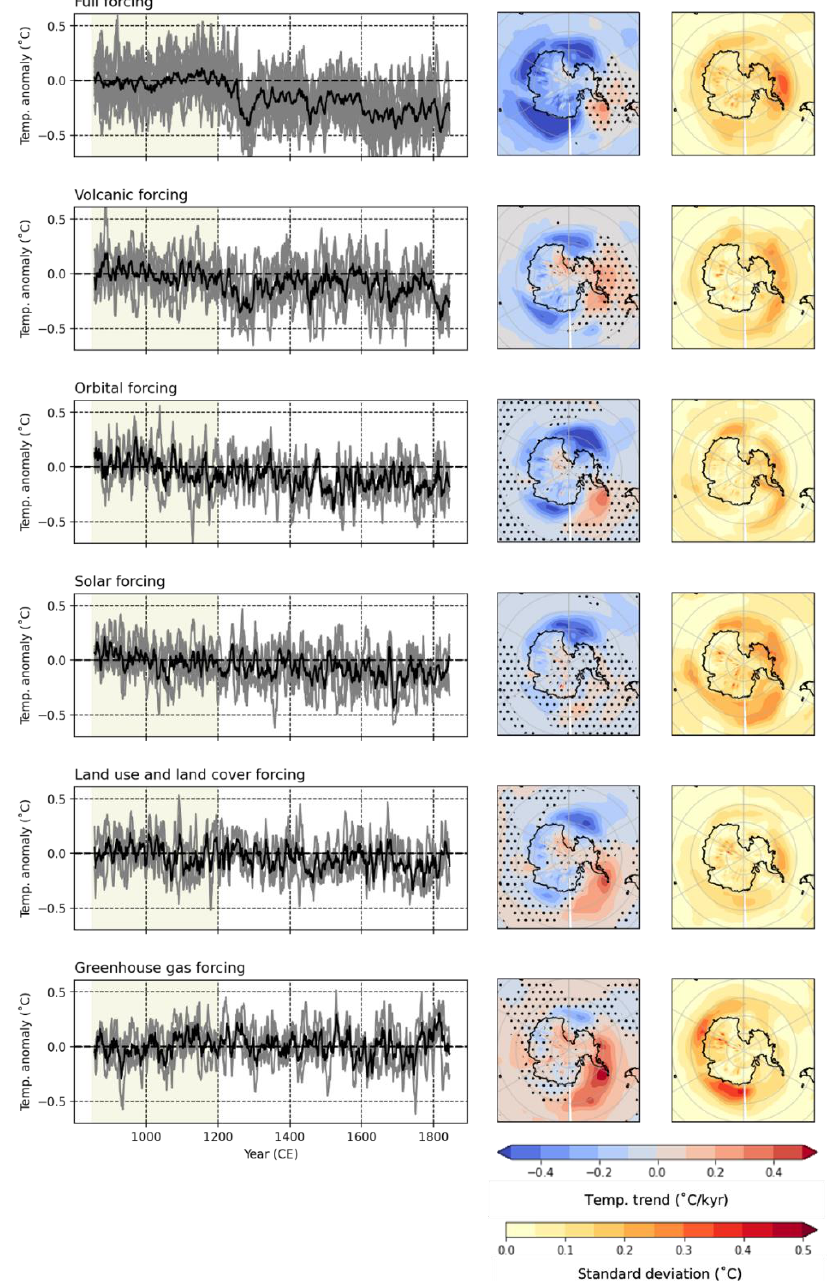
Figure 3. Antarctic (60 – 90° S) annual 2-m air temperature anomalies (°C) for the full forcing, volcanic, orbital, solar, land use and land cover, and greenhouse gas simulations. Timeseries of the temperature anomalies for each ensemble member (grey) and ensemble mean (black) were computed relative to the base period of 850 – 1200 CE (highlighted in beige), and a 10-year rolling mean was applied ( left ). Maps show the ensemble mean full LM (850:1850) linear trend ( center ) and standard deviation of the temperature trend ( right ); stippling indicates areas where the ensemble standard deviation is greater than the linear trend.